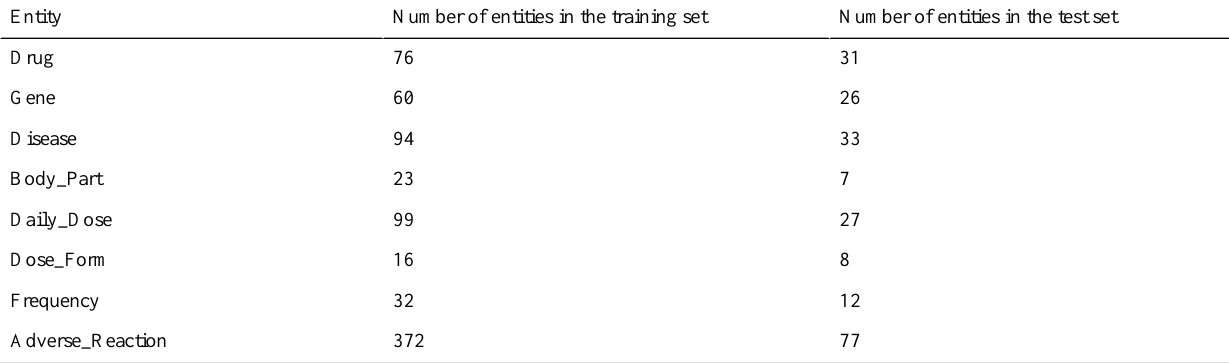
Table 2. Number of entities in training and test sets.